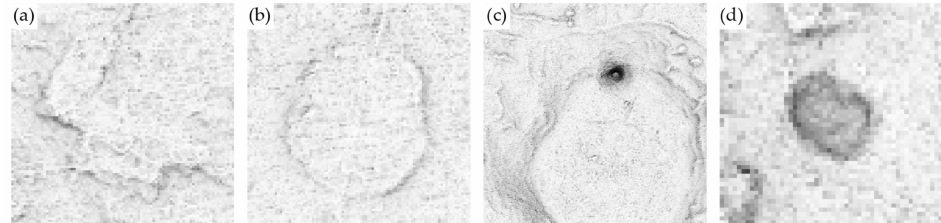
Figure 13. Misclassification of platforms with terrain and aguadas; ( a ) a platform misclassified as terrain, ( b ) a platform misclassified as an aguada, ( c ) terrain misclassified as a platform and ( d ) an aguada misclassified as a platform. Scale varies.